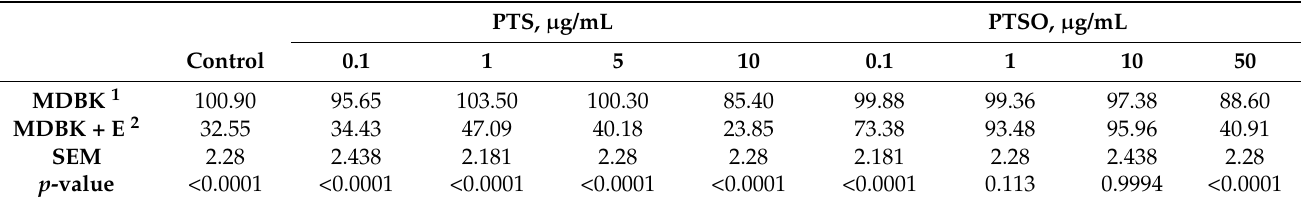
Figure 4. Effect of pre-incubation with PTS and PTSO on MDBK cells, estimated by qPCR: ( a ) number of E. acervulina gene copies detected in MDBK cells incubated at different PTS or PTSO concentrations 24 h before the infection with sporozoites; ( b ) percentage of inhibition of sporozoite invasion in MDBK cells incubated at different concentrations of PTS or PTSO before the infection with E. acervulina sporozoites. Different letters between columns indicate significant differences at p < 0.05. Table 1. Comparison between viability of non-infected or infected MDBK cells that were incubated during 24 h at the same concentrations of PTS or